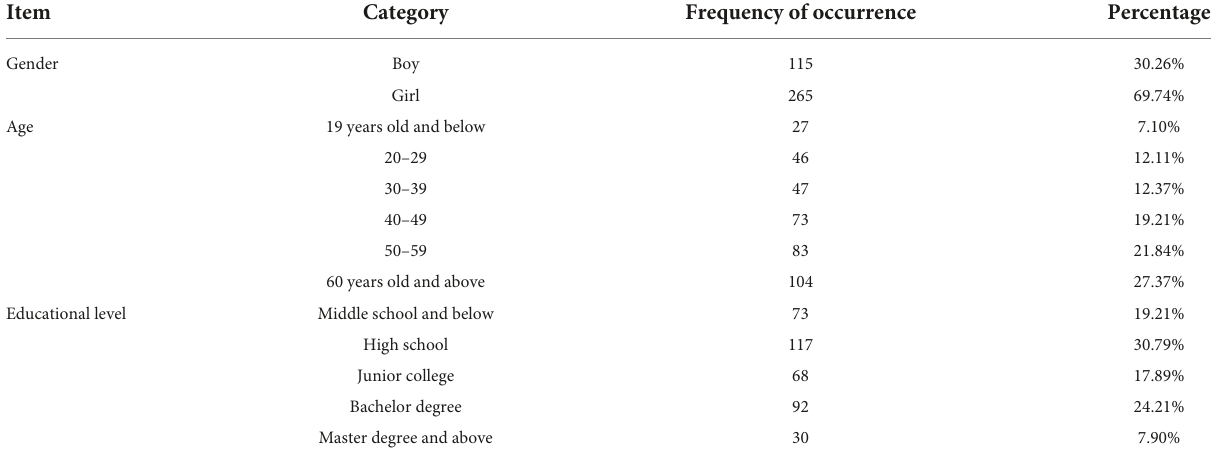
TABLE 2 Sample statistics for the